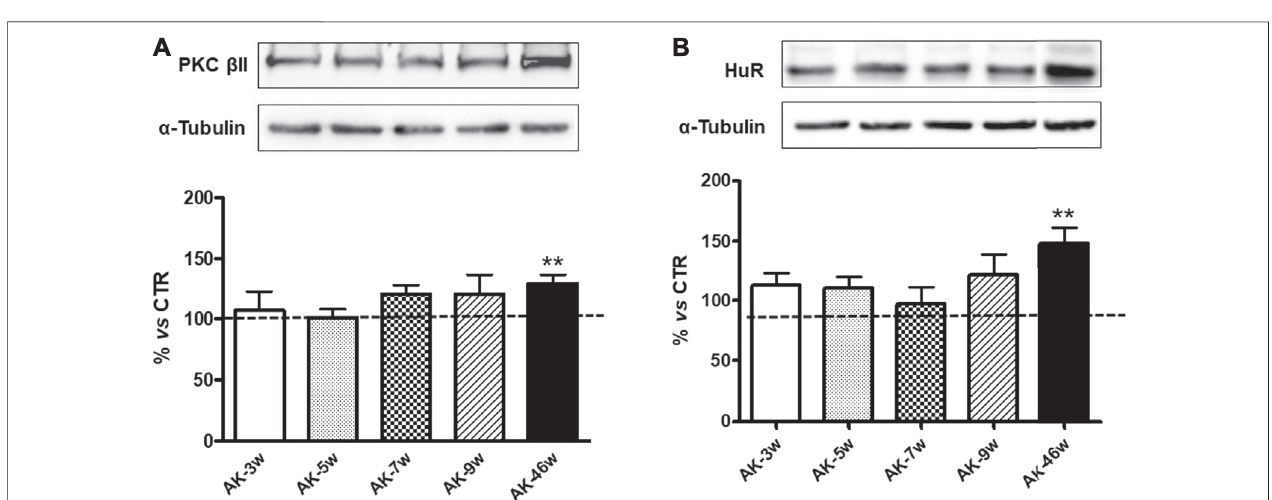
FIGURE 5 | PKC β II and HuR protein levels in Ins2 Akita mice at different ages. Upper panels: Representative western blottings of PKC β II (A) , HuR (B) and the respective α -tubulin, measured inthe same samples, of total homogenatesofretinaefrom Ins2 Akita (AK) mice at different ages (w (cid:2) weeks).Lower panels: Densitometric analysis of PKC β II (A) and HuR (B) immunoreactivities in the total homogenates of retinae from wild-type and AK mice at different ages. Alpha-tubulin was used as a loading control. Results are expressed as % ( ± S.E.M.) vs control wild-type (100%, dashed line). ** p < 0.01 vs wild-type; unpaired t -test, n (cid:2) 8 – 10.